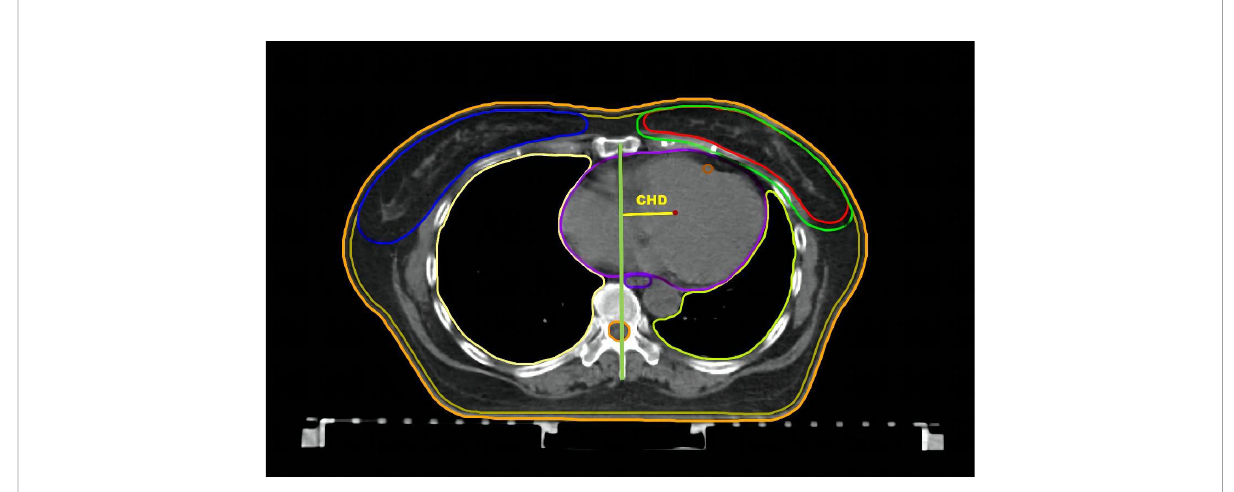
FIGURE 5 CHD in the supine CT. The central heart plane. The central heart distance (CHD) is the perpendicular distance from centre point of heart to the